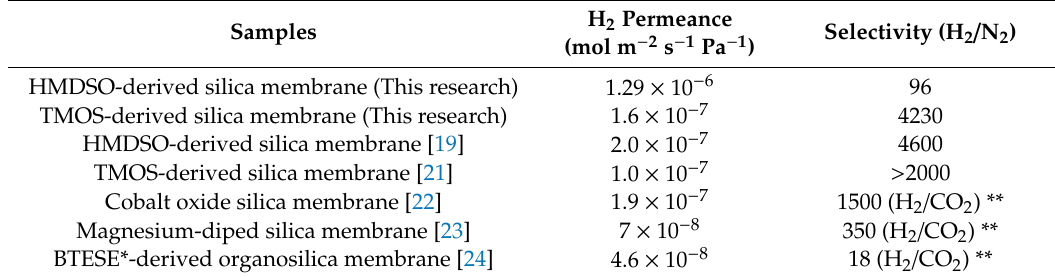
Table 3. The comparison table of hydrogen permeances and selectivity values of silica membranes, which are expected to have steam durability (at 573 K).